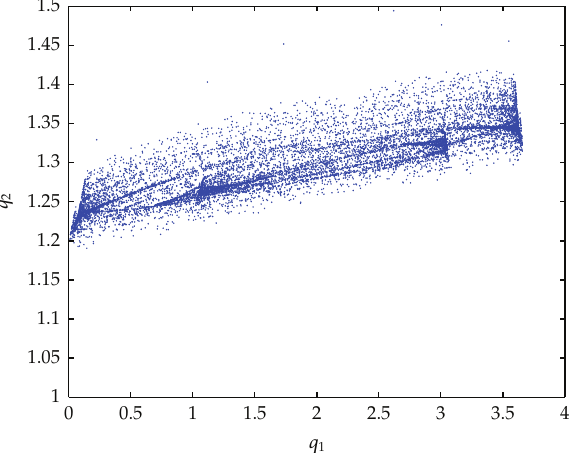
Figure 10: Strange attractor when β (cid:7) 0 . 2 ,α (cid:7) 23 .